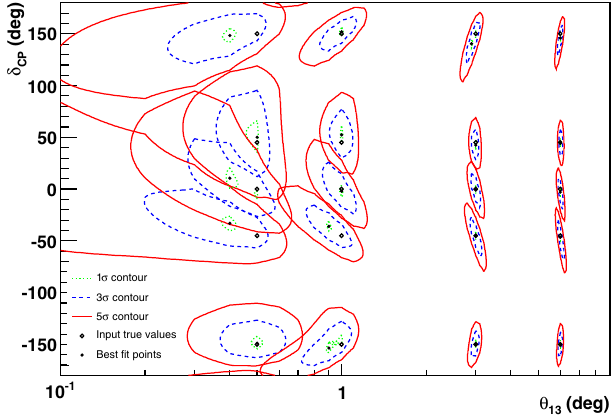
FIG. 20. Fits to simulated data using the near-far prediction assuming a normal mass